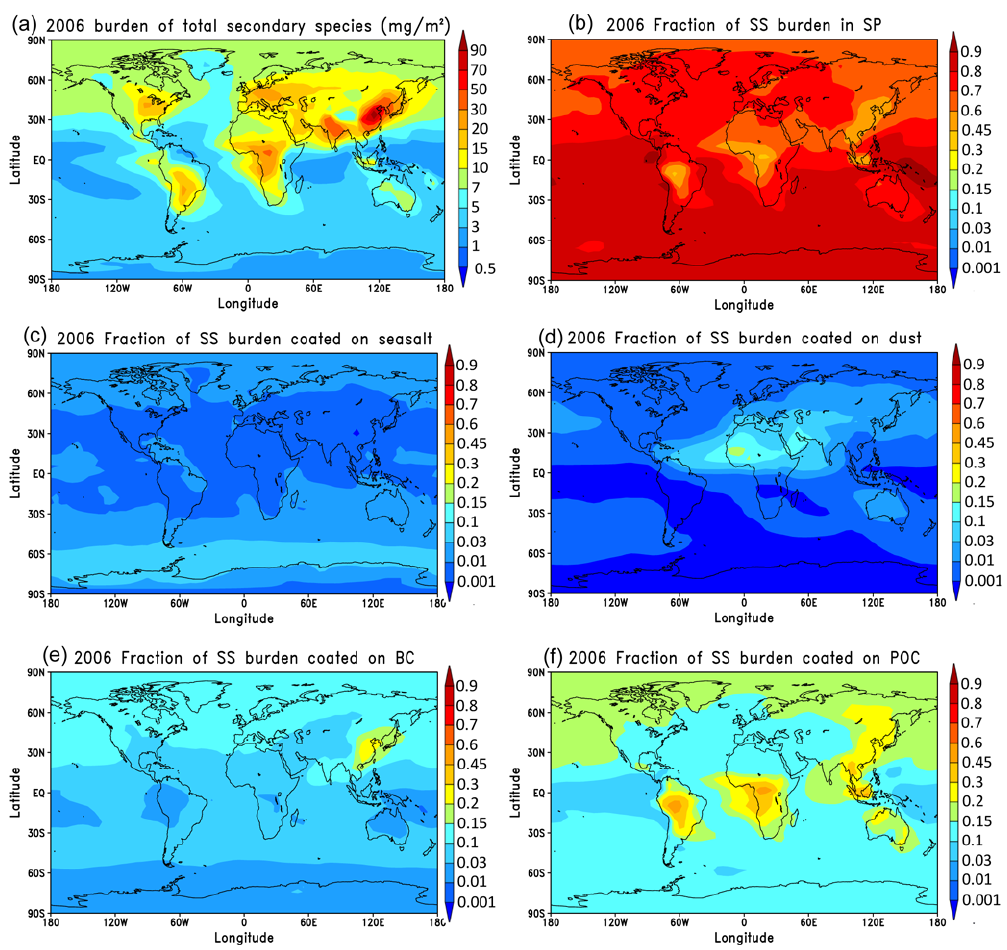
Fig. 3. Horizontal distribution of the column burden of total secondary species (SS, composed of sulfate, ammonium, nitrate, and SOAs), and the fractions of these species remaining in secondary particles (SP) and coated on each type of primary particles (dust, sea salt, BC, POC).